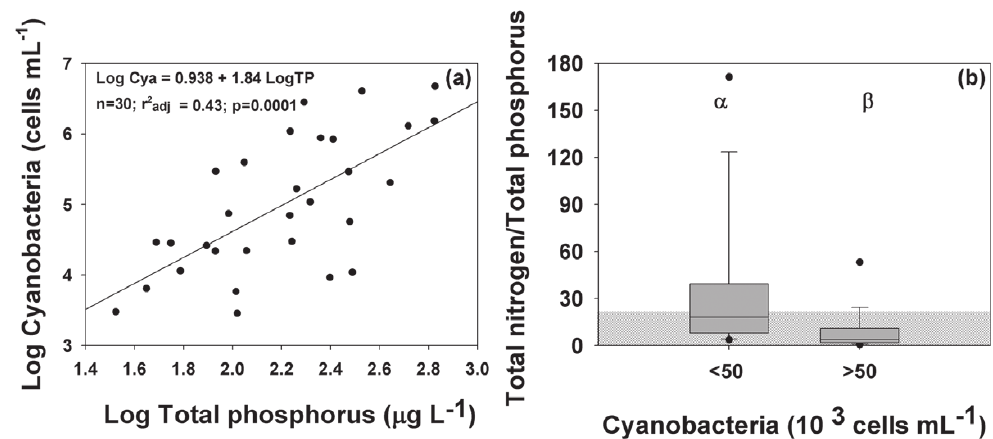
Figure 3 - (a) Relationship between Log Total phosphorus concentrations and Log Cyanobacterial abundance, showing the higher cyanobacterial abundance in higher TP concentrations; (b) Box plots of TN:TP ratios (by atom) in the fishponds where cyanobacteria abundances were higher and lower than 50,000 cells mL -1 . The gray area indicates N limitation. Significant differences (p<0.05) are indicated by different